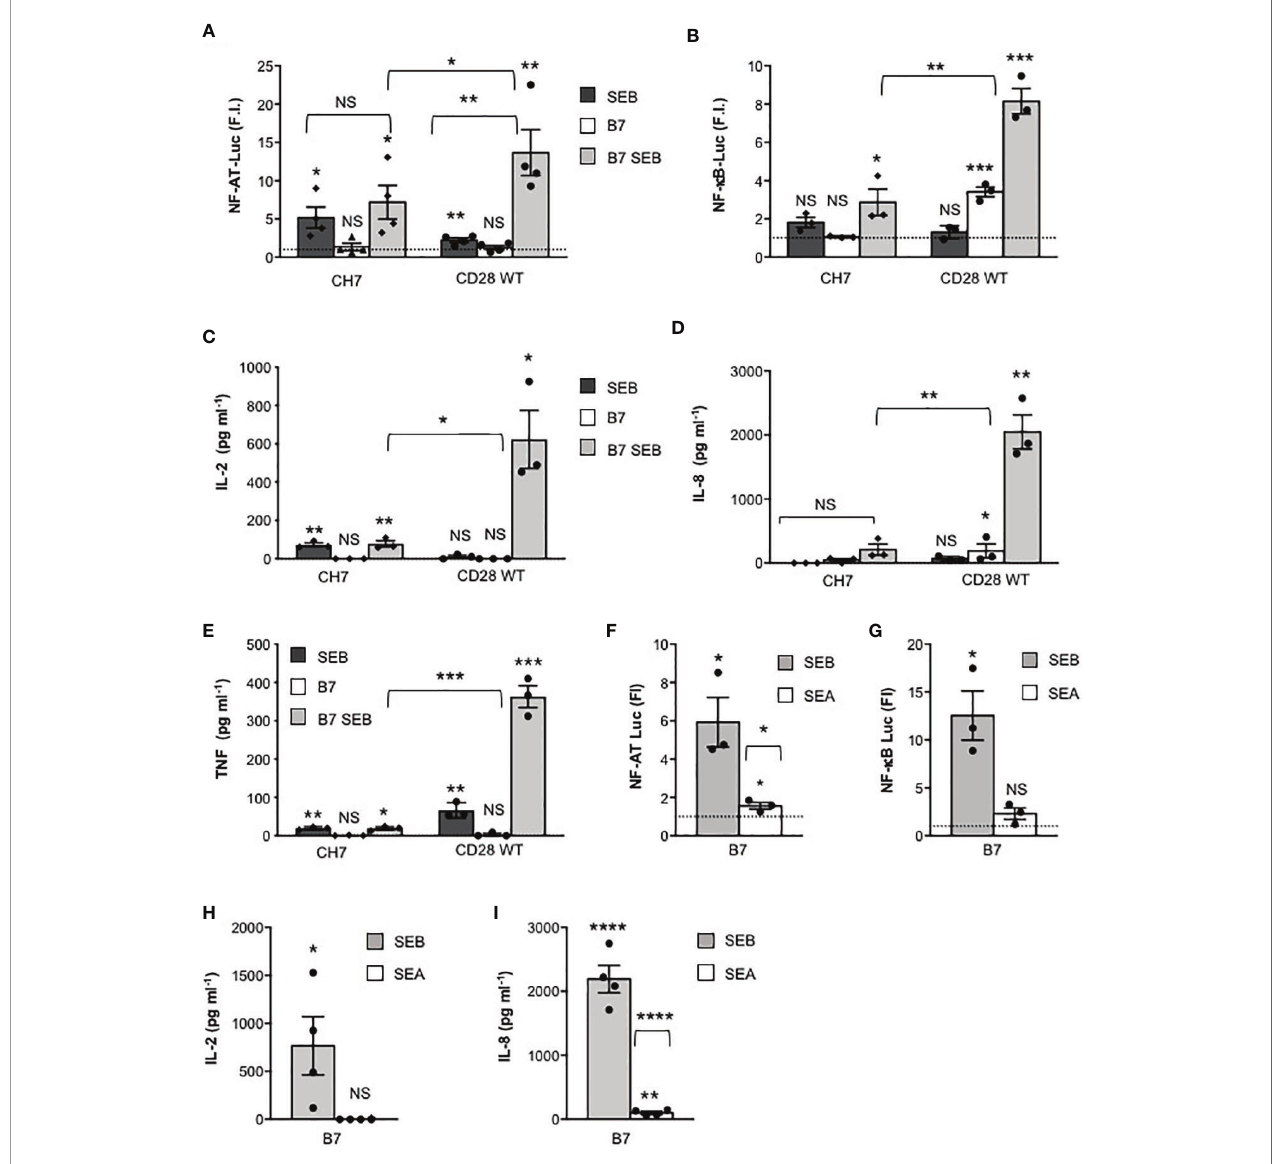
FIGURE 4 | SEB-induced in fl ammatory activity requires CD28 signalling. (A, B) CD28-negative CH7C17 (CH7) or CD28WT Jurkat cells transfected with NF-AT luciferase (A) or NF- k B-luciferase constructs (B) were left unstimulated or stimulated for 6 hours with 1 m g ml -1 SEB in the presence or absence of Dap3/B7 cells (B7). Bars show the mean fold induction (F.I) ± SEM after normalization to GFP values. Statistical signi fi cance was calculated by Student ’ s t test. Mean values: NF- AT, CH7 SEB = 5.1, CH7 B7 = 1.3, CH7 B7 SEB = 7.1, CD28WT SEB = 2.2, CD28WT B7 = 1.2, CD28WT B7 SEB = 13.6; NF- k B, CH7 SEB = 1.8, CH7 B7 = 1, CH7 B7 SEB = 2.8, CD28WT SEB = 1.3, CD28WT B7 = 3.4, CD28WT B7 SEB = 8.1. (C – E) CH7 or CD28WT cells were cultured for 24 hours with medium (Med) or SEB in presence or absence of Dap3/B7 (B7) and IL-2 (C) , IL-8 (D) and TNF levels (E) in culture supernatants were measured by ELISA. Bars show the mean ± SEM of three independent experiments. Statistical signi fi cance was calculated by Student ’ s t test. Mean values: IL-2 CH7, Med = 0 pg ml -1 , SEB = 72.8 pg ml -1 , B7 = 0 pg ml -1 , B7 SEB = 77.7 pg ml -1 ; IL-2 CD28WT, Med = 0 pg ml -1 , SEB = 11.2 pg ml -1 , B7 = 0 pg ml -1 , B7 SEB = 622.9 pg ml -1 ; IL-8 CH7, Med = 0 pg ml -1 , SEB = 46 pg ml -1 , B7 = 0 pg ml -1 , B7 SEB = 209.7 pg ml -1 ; IL-8 CD28WT, Med = 5.1 pg ml -1 , SEB = 189.7 pg ml -1 , B7 = 67.7 pg ml -1 , B7 SEB = 2051 pg ml -1 ; TNF CH7, Med = 1.4 pg ml -1 , SEB = 19.3 pg ml -1 , B7 = 0.5 pg ml -1 , B7 SEB = 19.1 pg ml -1 ; TNF CD28WT, Med = 1.1 pg ml -1 , SEB = 66.3 pg ml -1 , B7 = 3 pg ml -1 , B7 SEB = 362.9 pg ml -1 . NF-AT (F) and NF- k B (G) luciferase activities of CD28WT stimulated for 6 hours with 1 m g ml -1 SEB or SEA in the presence of Dap3/B7 cells (B7). The results were expressed as fold inductions (F.I.) over the basal level of luciferase activity in unstimulated cells. Data show the mean F.I. ± SEM after normalization to GFP expression. Statistical signi fi cance was calculated by Student ’ s t test. Mean values: NF-AT, B7 SEB = 5.928, B7 SEA = 1.559; NF- k B, B7 SEB = 12.54, B7 SEA = 2.313. (H, I) CD28WT cells were stimulated for 24 hours with SEB or SEA in presence of Dap3/B7 (B7). IL-2 (H) and IL-8 (I) levels in culture supernatants were measured by ELISA. Data show the mean ± SEM of four independent experiments. Signi fi cance was calculated by Student ’ s t test. Mean values: IL-2, Med = 0 pg ml -1 , B7 SEB = 765.1 pg ml -1 , B7 SEA = 0 pg ml -1 IL-8, Med = 0 pg ml -1 , B7 SEB = 2191 pg ml -1 , B7 SEA = 100.8 pg ml -1 . (*) p < 0.05, (**) p < 0.01, (***) p < 0.001, (****) p < 0.0001, NS, not signi fi